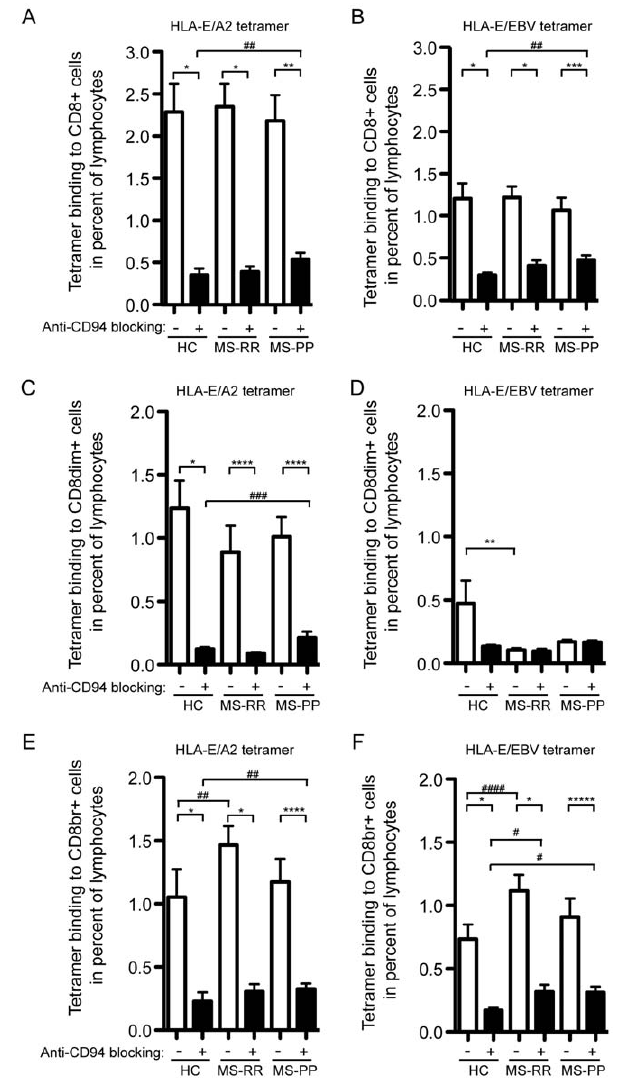
Figure 4. Increased frequency of cells recognizing HLA-E/ BZLF1 by CD8 bright cells in a CD94-independent manner in MS- RR and MS-PP patients. Tetramer HLA-E/A2 binding to CD8 total (A), CD8 bright (C), and CD8 dim (E) and tetramer HLA-E/BZLF1 binding to CD8 total (B), CD8 bright (D), and CD8 dim (F) are all expressed as percentage binding within lymphogate. Binding is analysed in the presence or absence of anti-CD94 blocking antibody. Comparisons between presence and absence of anti-CD94 are done using paired T-test. Other comparisons are done using Mann-Whitney U-test. The symbols indicating different p values are: * p # 0.0001, ** p # 0.001, *** p # 0.005, **** p # 0.003, ***** p # 0.007, # p # 0.01, ## p # 0.02, ### p # 0.03, #### p # 0.04.